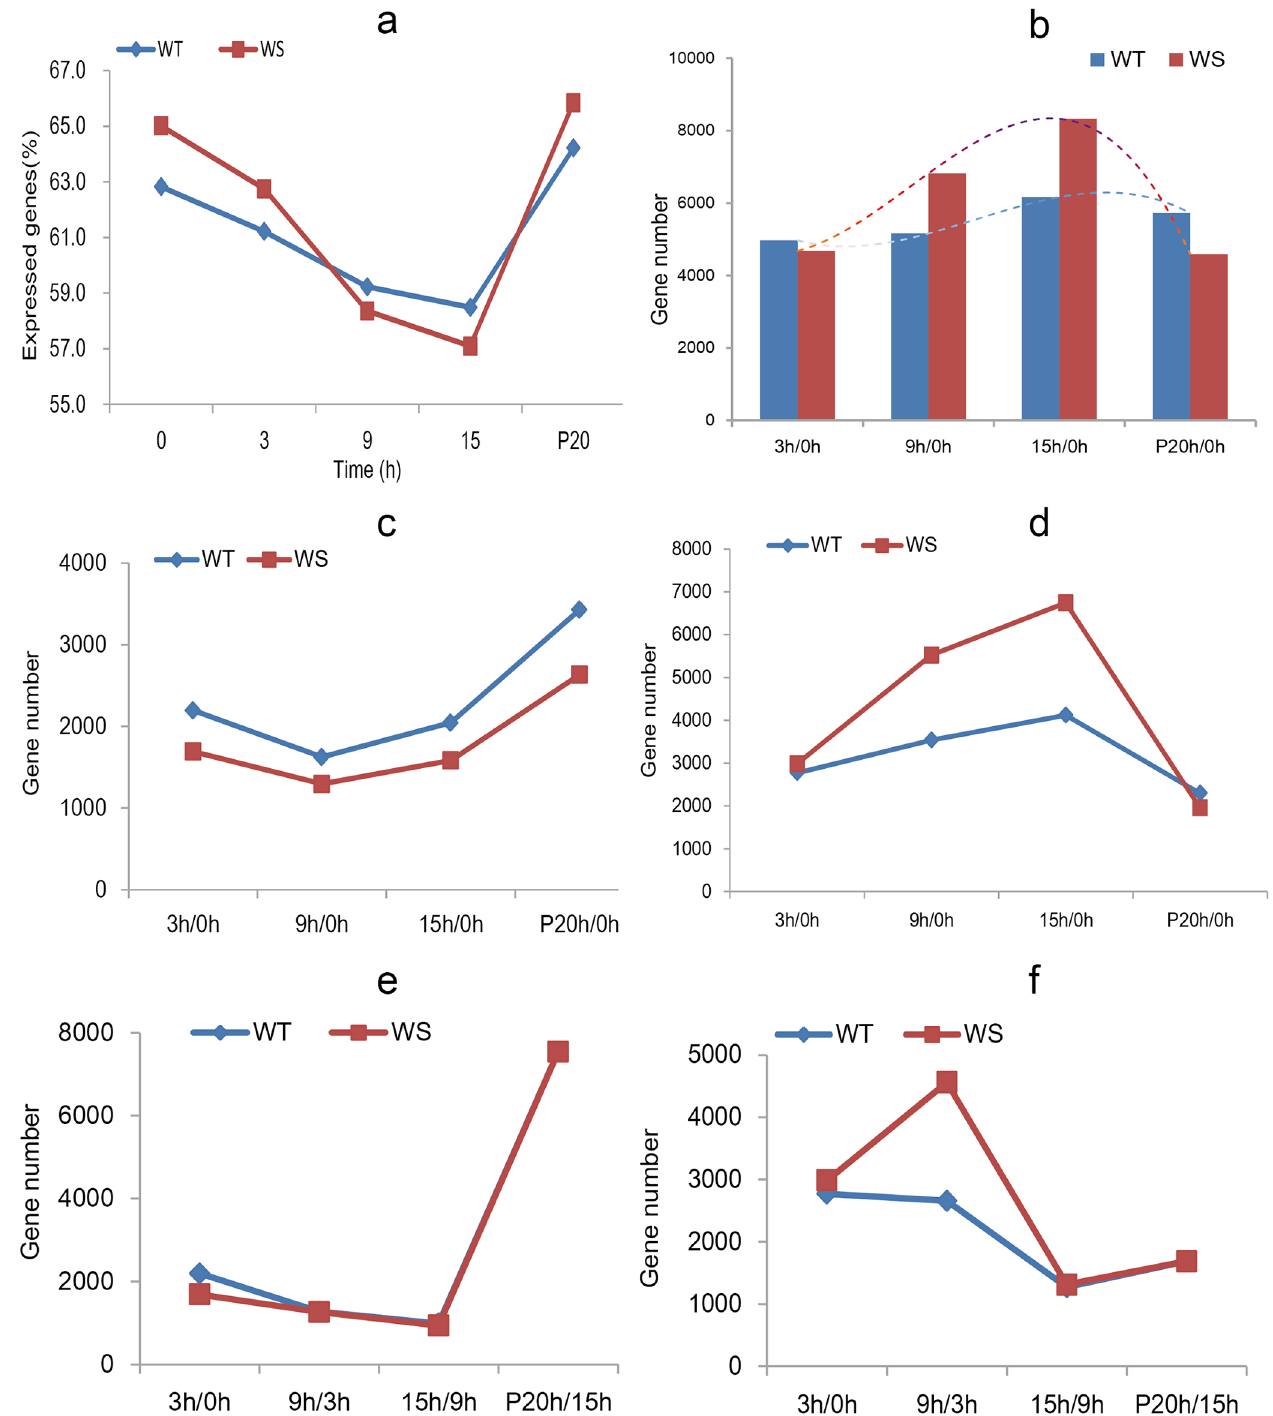
Fig 2. Changes in gene expression in WT and WS plants. (a) Percentages of the expressed genes during waterlogging from 0 to 15 h as well as 20 h post drainage. (b) The number of genes significantly affected by the stress. (c) Upregulated genes using 0 h as a control. (d) Downregulated genes using 0 h as a control. (e) Upregulated genes using the former sampling point as a control, illustrating the dynamic changes in differentially expressed genes (DEGs) in sesame upon waterlogging exposure. (f) Downregulated genes using the former sampling point as a control.